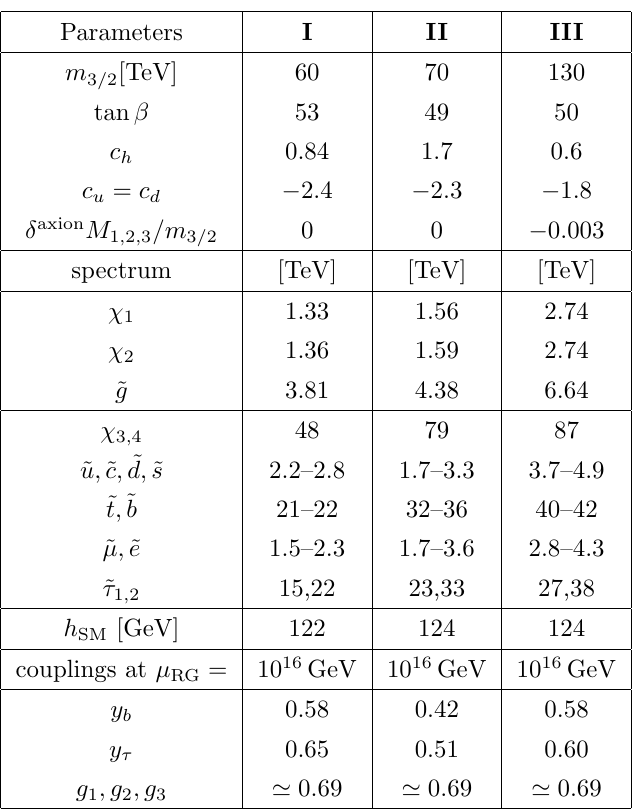
Table 1 . Sample data points. The model parameters except for tan (cid:12) are set at M inp = 10 16 GeV : All the points give the correct dark matter abundance (cid:10) (cid:31)